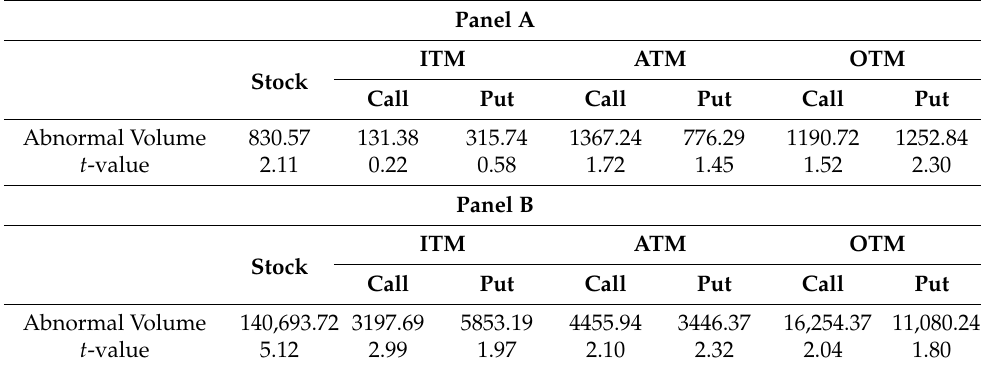
Table 4. Abnormal Trading of Merging Firms.